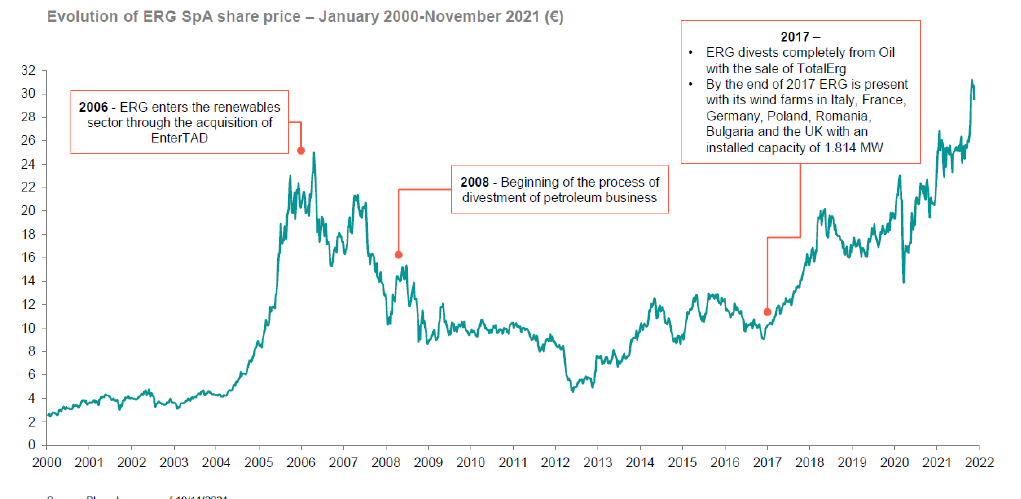
Figure 1: Chart on the Performance of the Erg